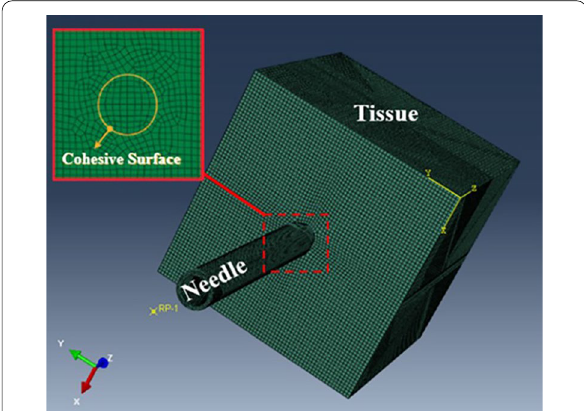
Figure 7 Finite element meshing and attribute